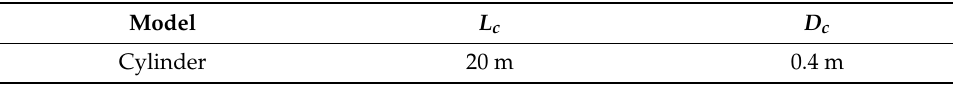
Figure 5. Simulated simple cylinder. Table 1. Parameters of the simulated